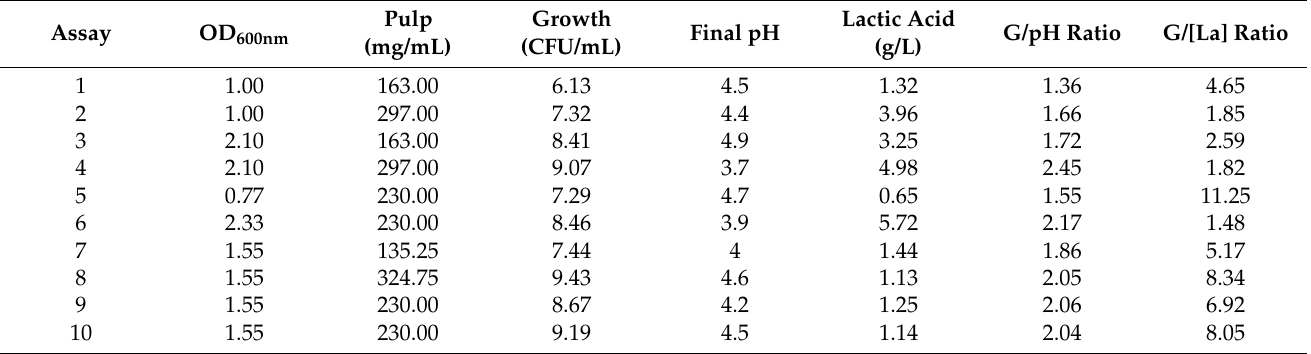
Figure 1. Growth and production of lactic acid by Lacticaseibacillus rhamnosus in cupuaçu juice. ( A ) Survival of L. rhamnosus ATCC 9595 in the fermentations of cupuaçu juice by L. rhamnosus ATCC 9595 during the storage period. ( B ) Response surface obtained for RVpH as a function of pulp and inoculum concentrations in cupuaçu juice fermentations by L. rhamnosus ATCC 9595. ( C ) Response surface obtained for lactic acid concentration as a function of pulp and inoculum concentrations in cupuaçu juice fermentations by L. rhamnosus ATCC 9595. Table 3. Effects of inoculum density and pulp concentration on growth and lactic acid production by L. rhamnosus ATCC 9595 in cupuaçu juice.